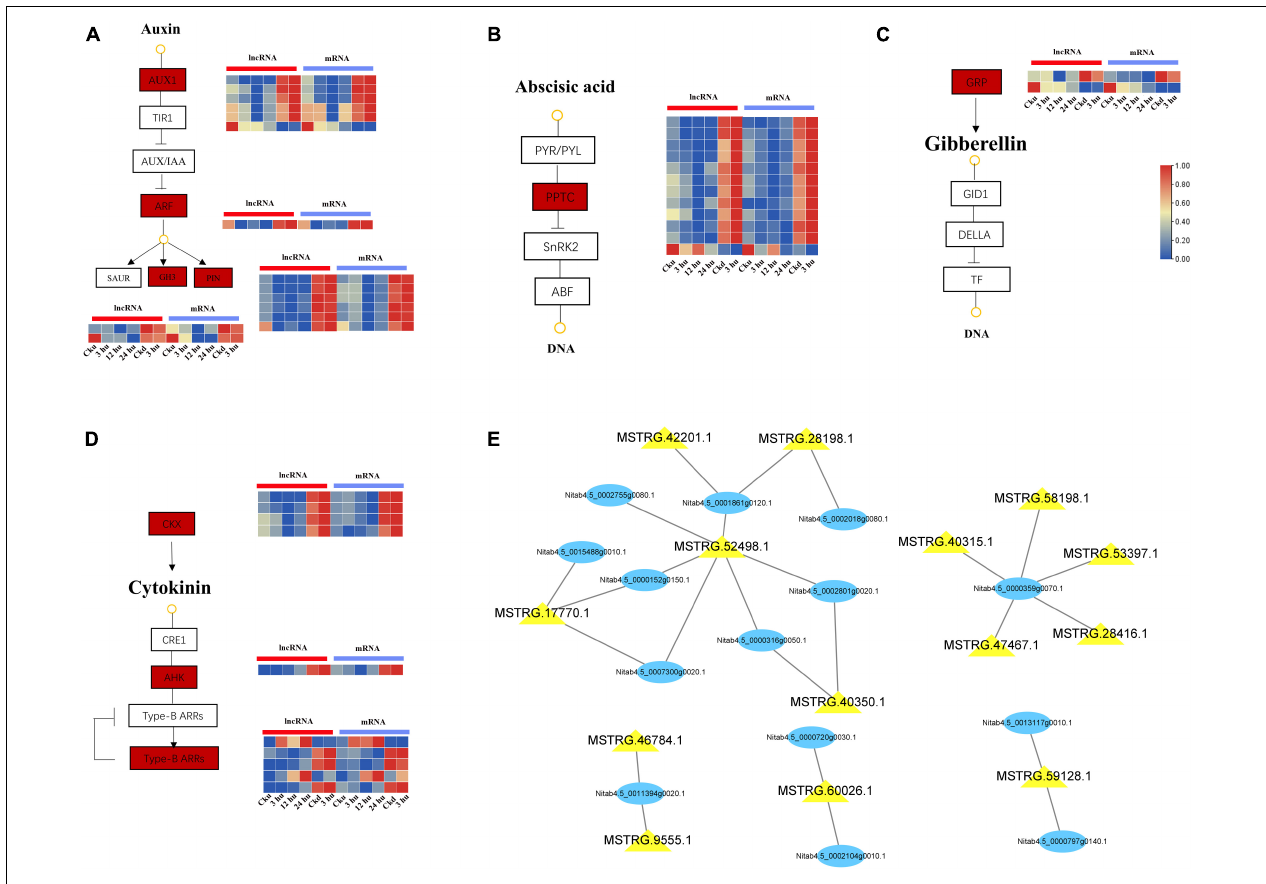
FIGURE 3 | Expression patterns of lncRNAs and mRNAs involved in hormone signal transduction pathways of upper and lower axillary bud. All the heatmaps were generated using Tbtools software with log 2 transformed FPKM values. (A) lncRNAs and mRNAs involved in auxin signal transduction pathway. (B) lncRNAs and mRNAs involved in abscisic acid signal transduction pathway. (C) lncRNAs and mRNAs involved in cytokinin signal transduction pathway. (D) lncRNAs and mRNAs involved in gibberellin signal transduction pathway. The boxes represent mRNAs and lncRNAs. (E) mRNA-lncRNA interaction networks in the hormone signal transduction pathways. Blue nodes represent mRNAs, and yellow nodes represent